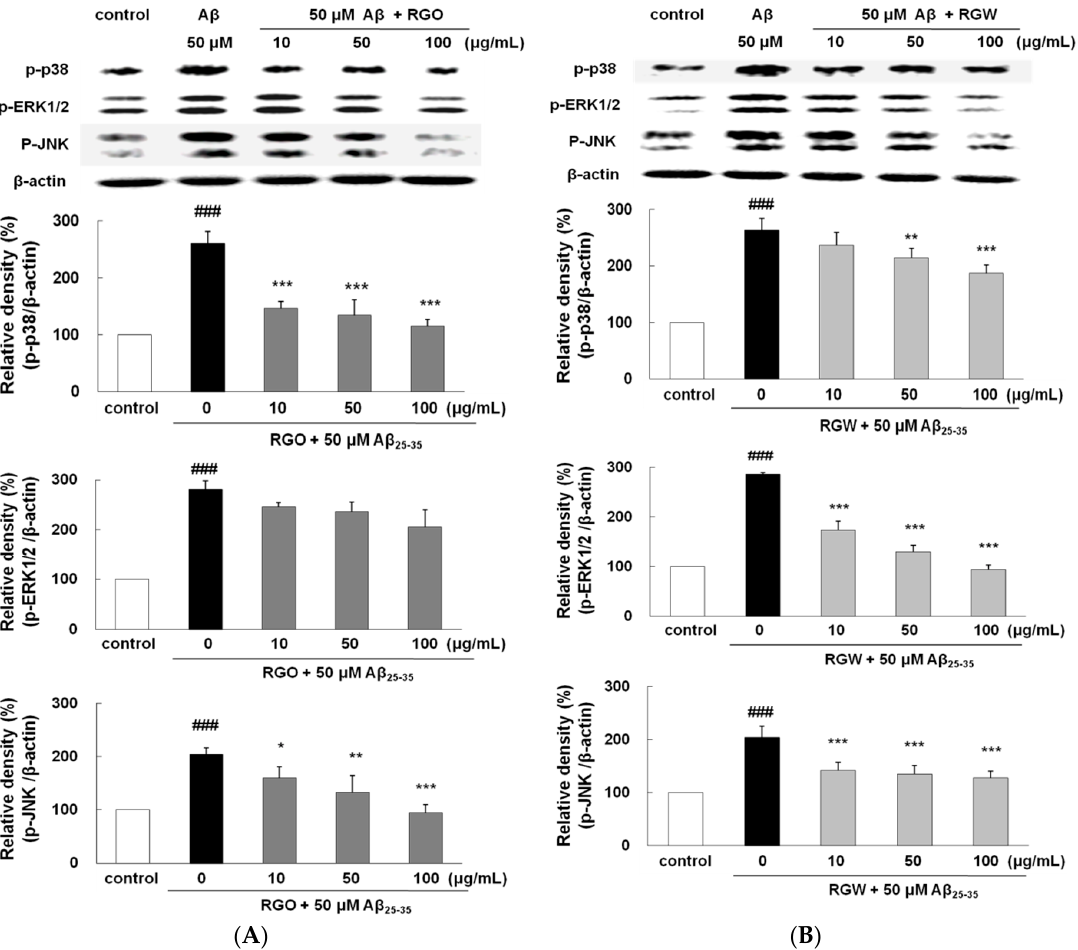
Figure 8. RGO ( A ) and RGW ( B ) ameliorated A β 25–35 -stimulated MAPKs phosphorylation. PC12 cells were treated with A β 25–35 for 1 h and then cellular lysates were analyzed by Western blot assay. The separated proteins were analyzed by Western blot analysis as described in Materials and Methods.